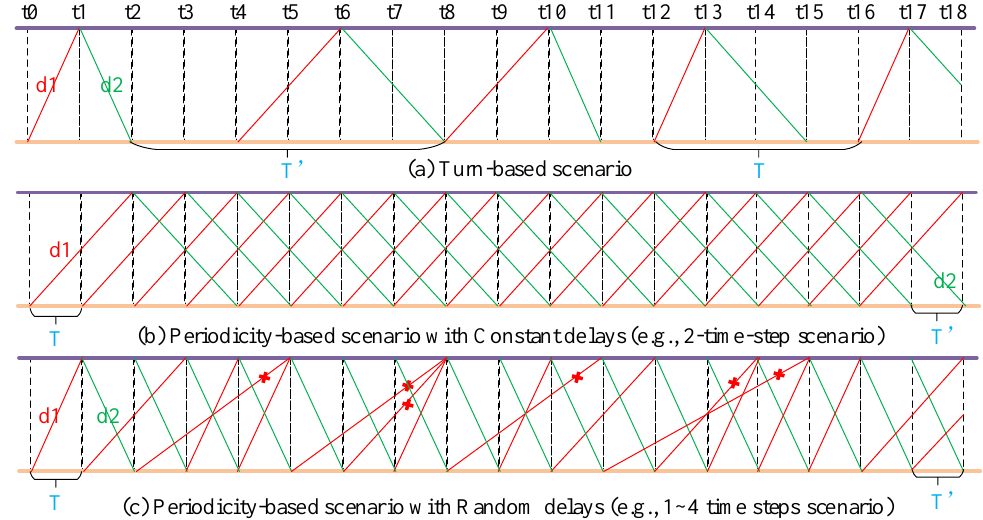
Figure 1. Different interaction scenarios between the agent and the underlying networks considering different delay patterns. d 1 and d 2 are delays for state collection and action execution, respectively. T denotes the time interval of state collection and T (cid:48) is the time interval of action execution. The red symbols such as “x” (as shown in ( c )) mean that the collected states will not be used to generate the next action. The red lines are the processes for state collection, while the green lines are for action execution. Here, we assume that the action delays are